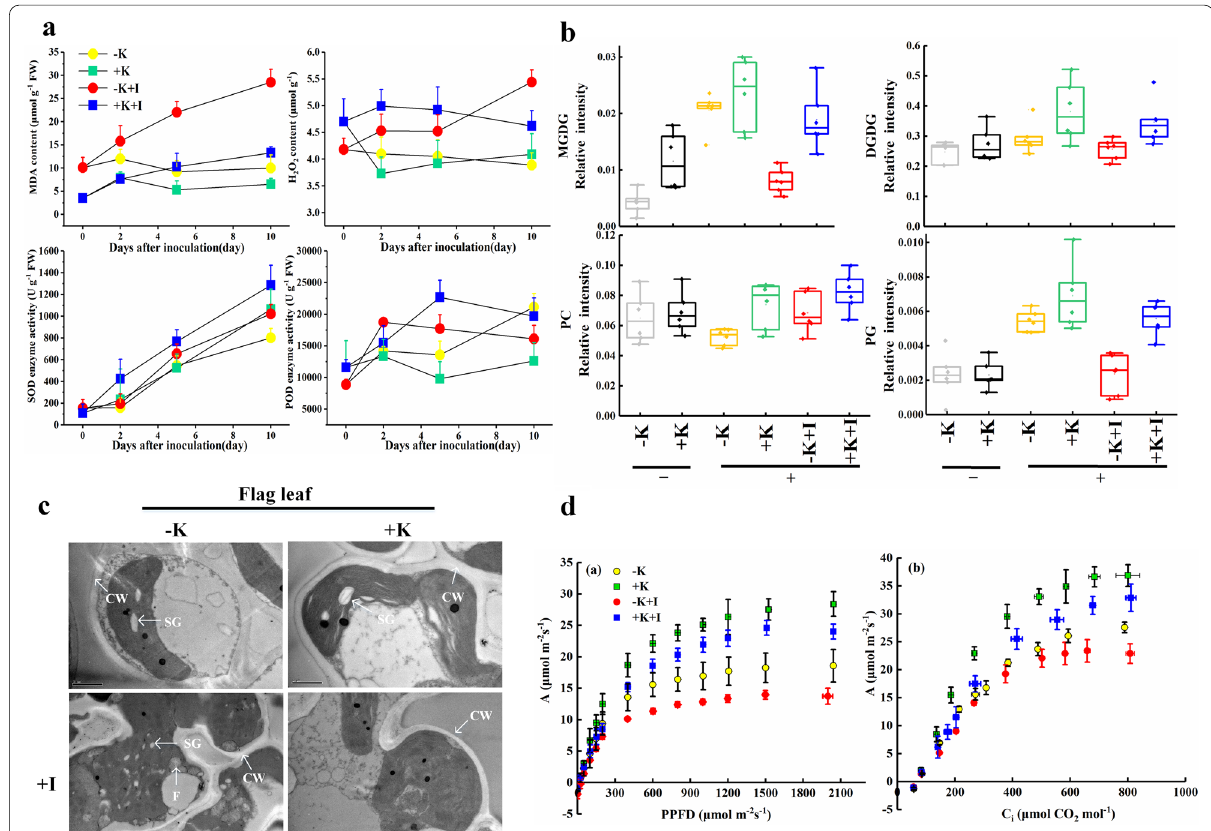
Fig. 6 K deficiency aggravates membrane lipid peroxidation and induces a flag leaf response to S. oryzae infection. a MDA and H 2 O 2 contents and activities of SOD and POD. The error bars on the top of the point denote the least significant difference among treatments at the same sampling date at p < 0.05; the abbreviations of the treatments, K represent potassium; I represent inoculation with S. oryzae ; “ without K, respectively. b The contents of MGDG, DGDG, PC, and PG; “ c Ultrastructure of a chloroplast in the flag leaf. In the picture, CW, SG, and F represent the cell wall, starch grain, and a lipid droplet, respectively.